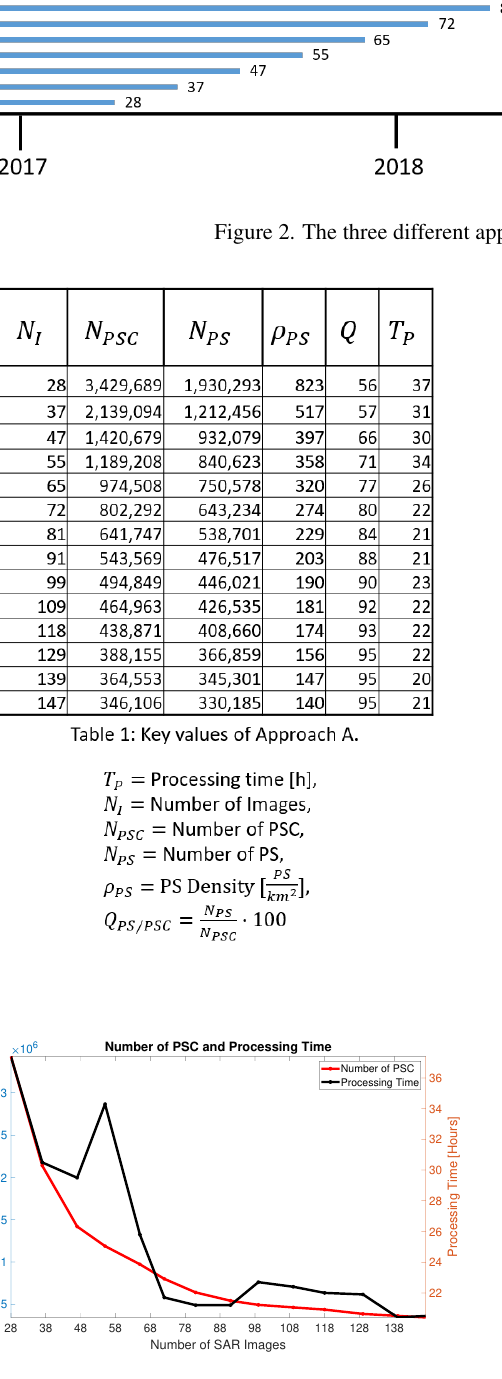
Figure 3. Number of PSC and the processing time (Approach A).